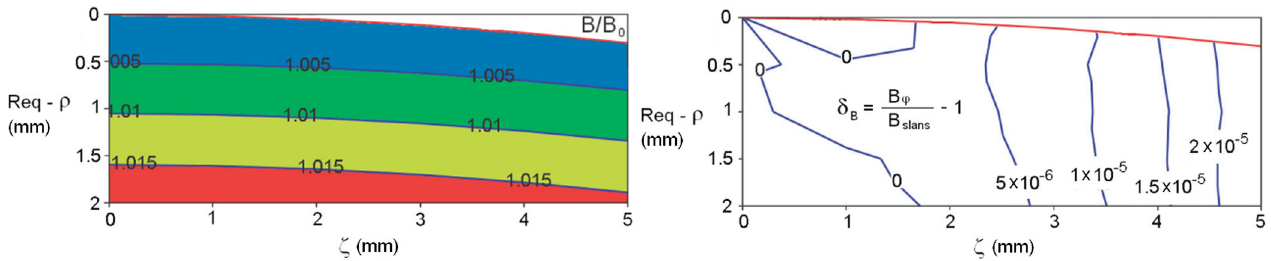
FIG. 5. Left: Magnetic field in the TESLA cavity near the equator. Right: Difference between results calculated with SLANS and with formula